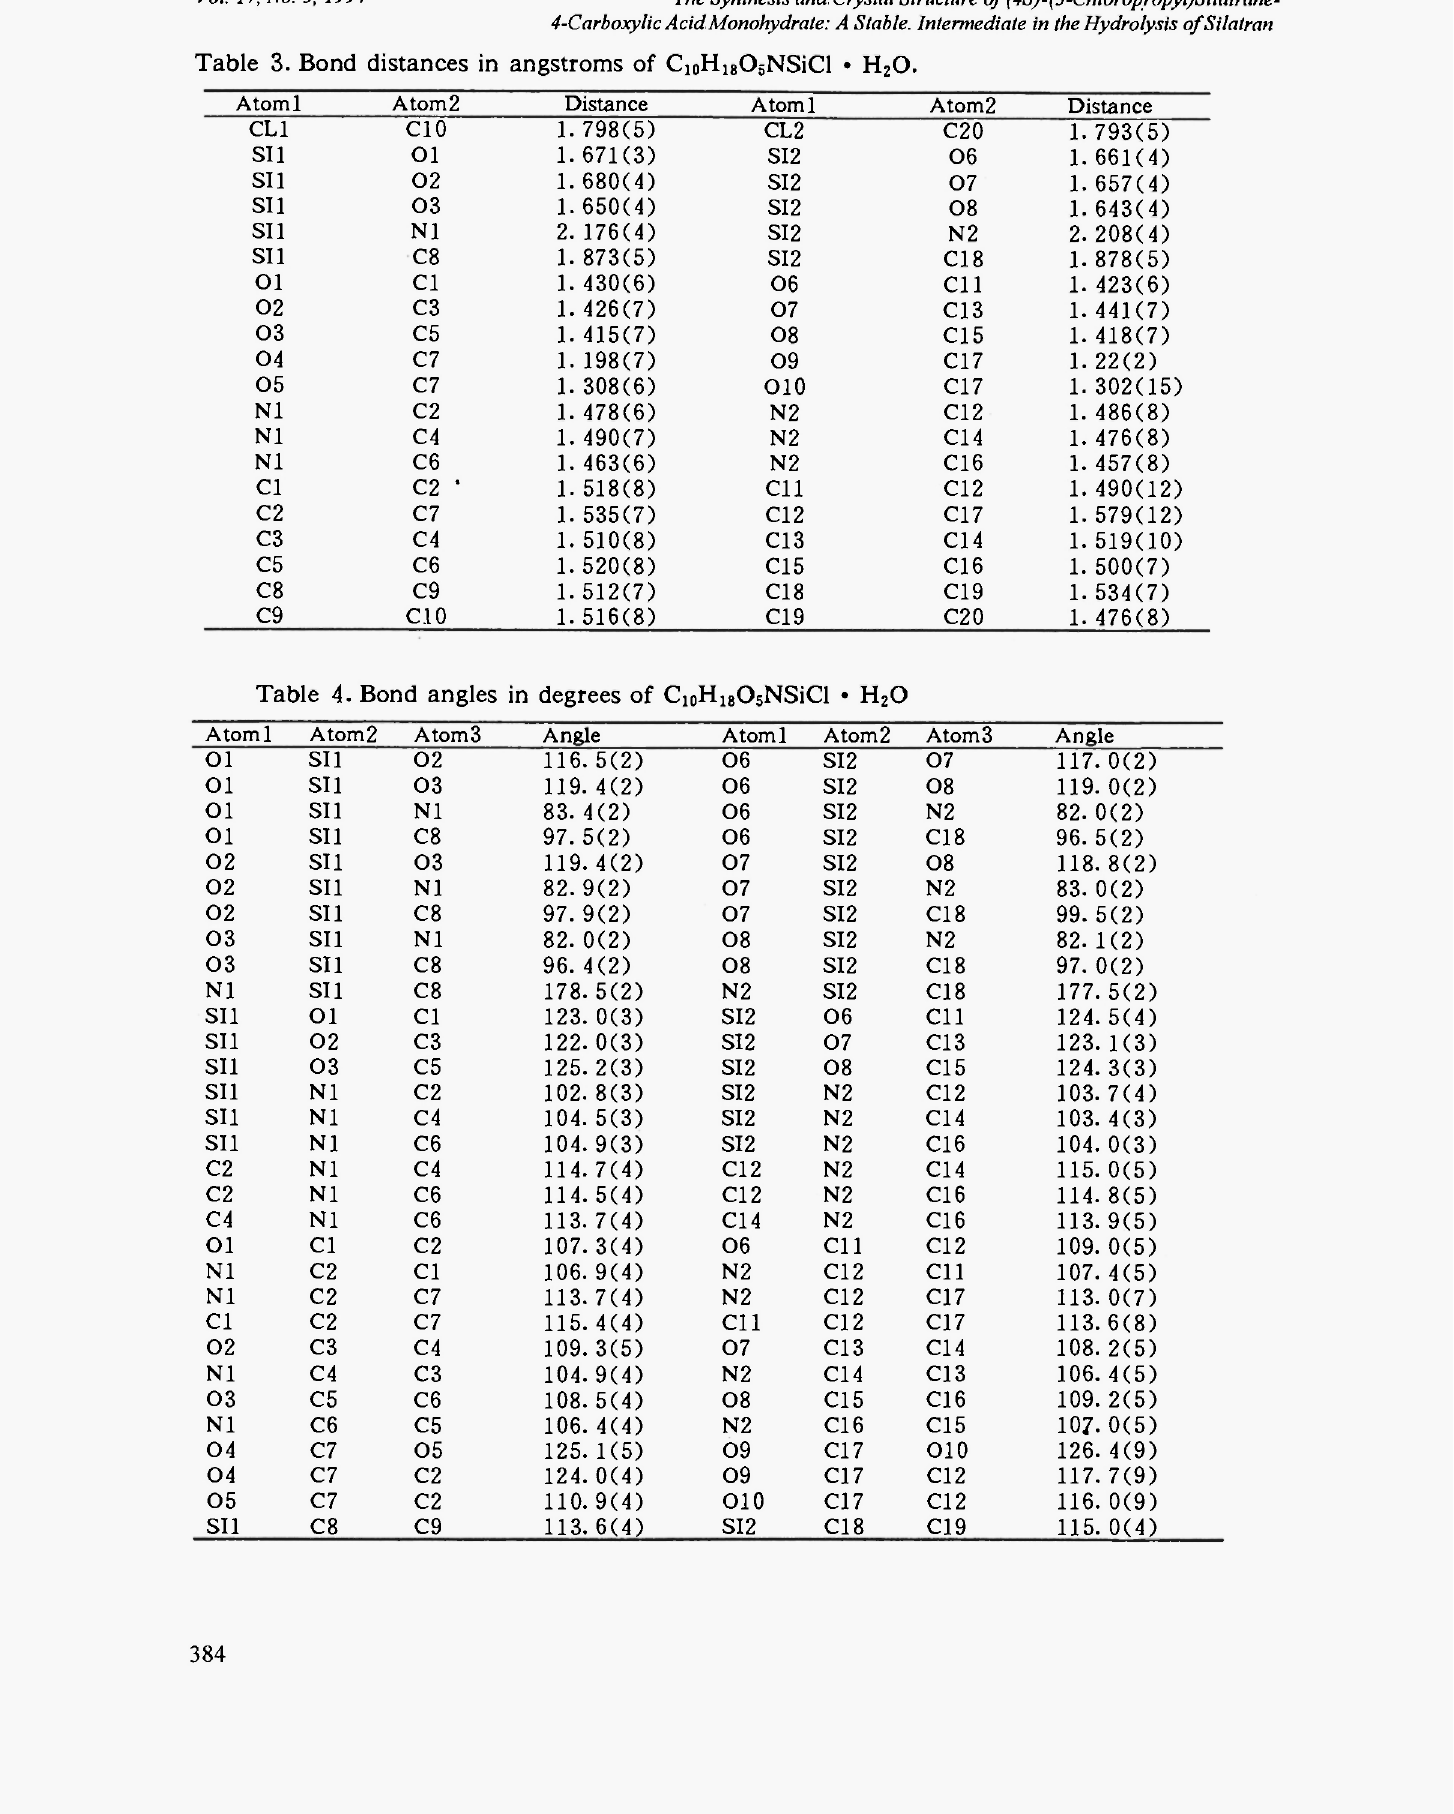
H O NSiCl · H 10 18 5